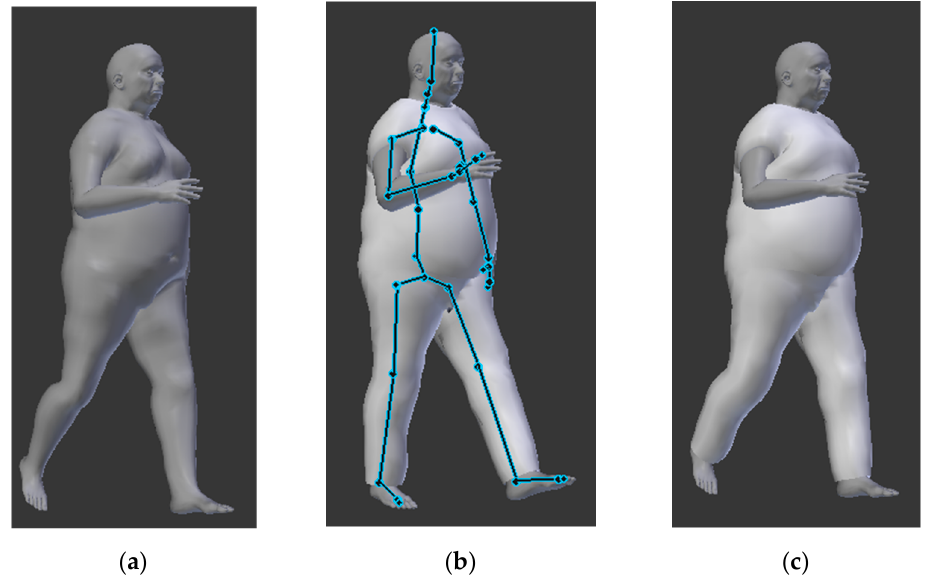
Figure 3. Kinematic model in Blender (( a ) statistical body shape model, ( b ) parenting of the mesh with the armature, ( c ) rigging of the statistical shape model with the cloth and the bvh file).